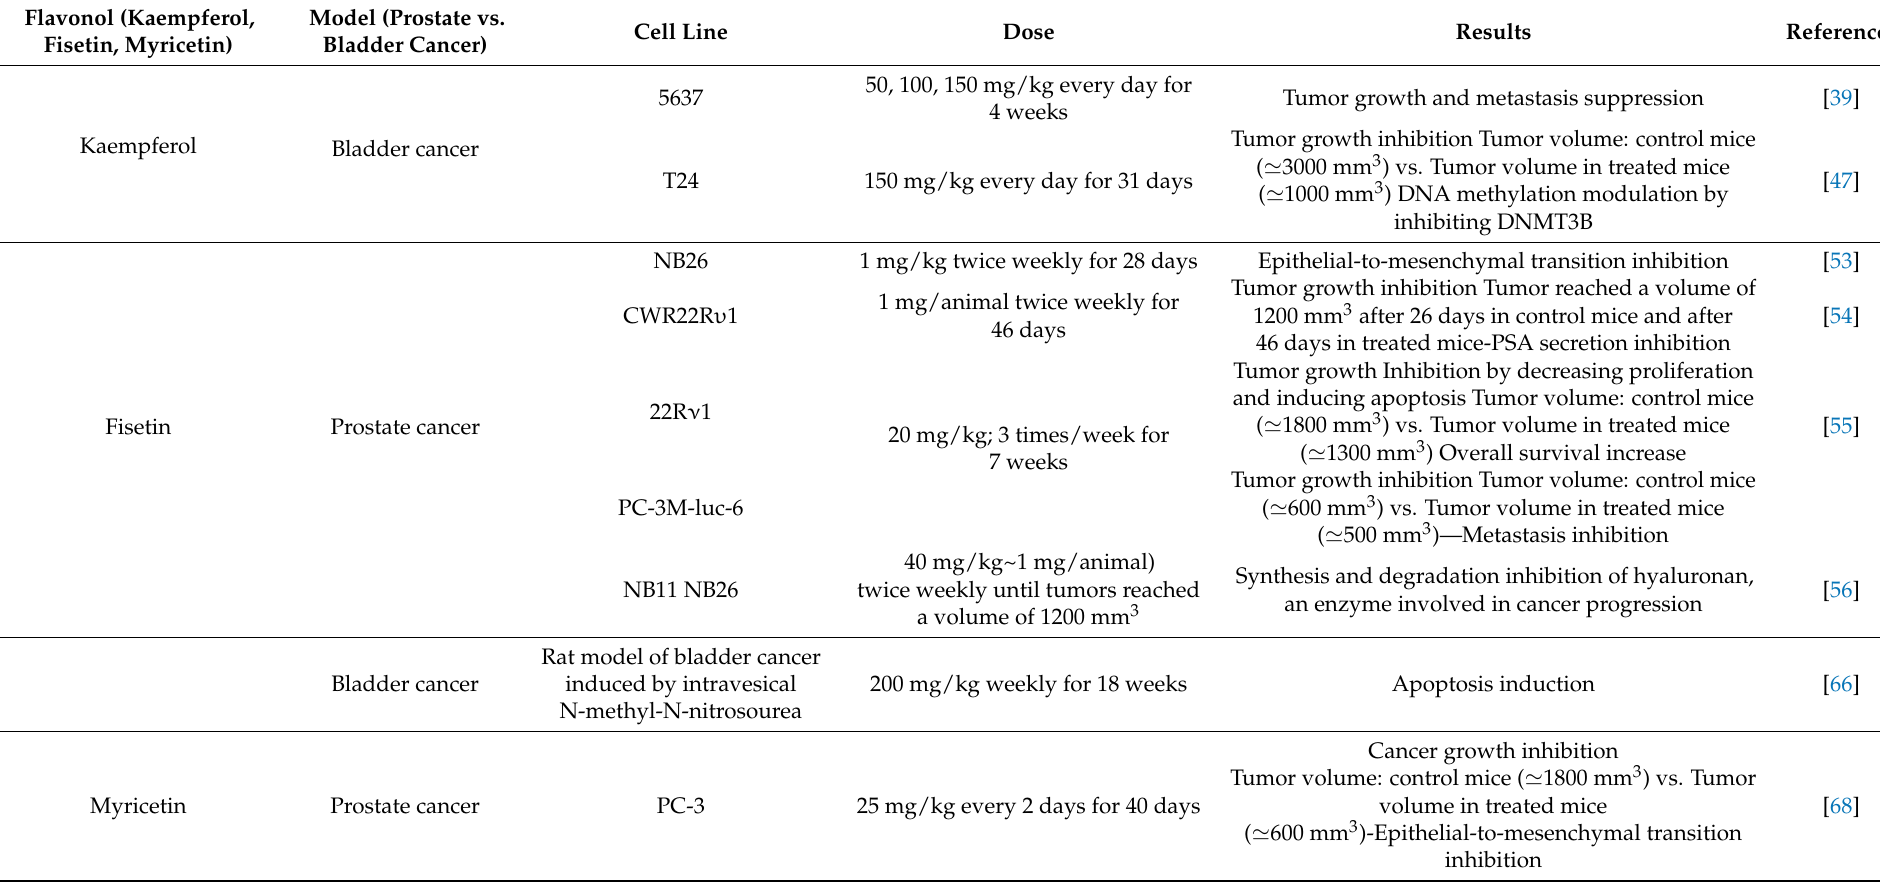
Table 3. Results of animal